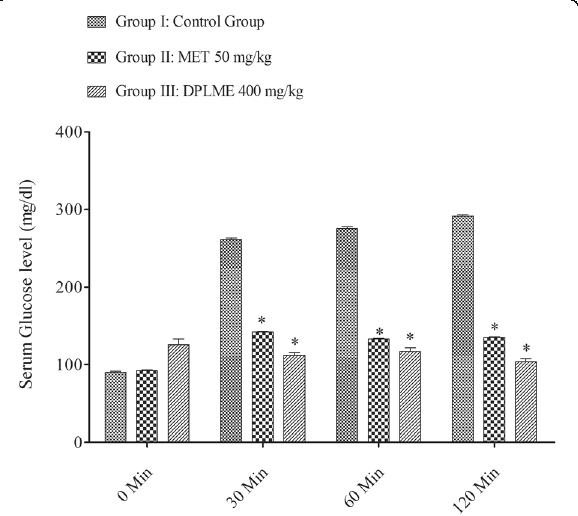
Fig. 1 Effects of D. pentandra leaf methanolic extract on fasting rats after oral glucose intake. Values are expressed as mean ± SEM ( n = 4). * p < 0.05 denotes statistically significant result for a group when it was compared with the hyperglycemic control group (Group